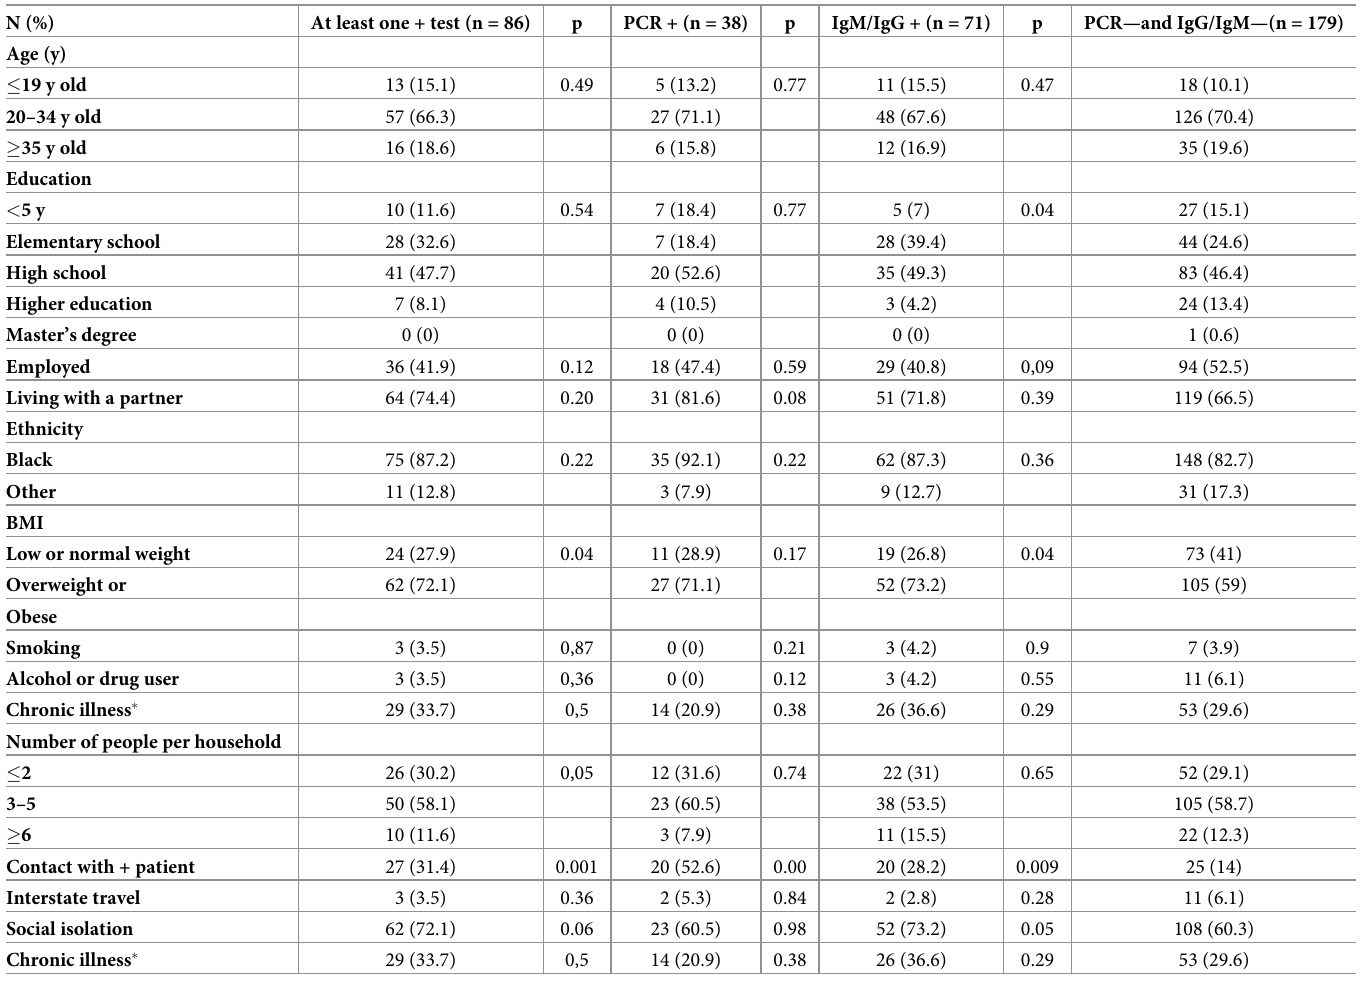
Table 1. Sociodemographic, clinical and behavioral data of pregnant women by test type and result (N = 265).